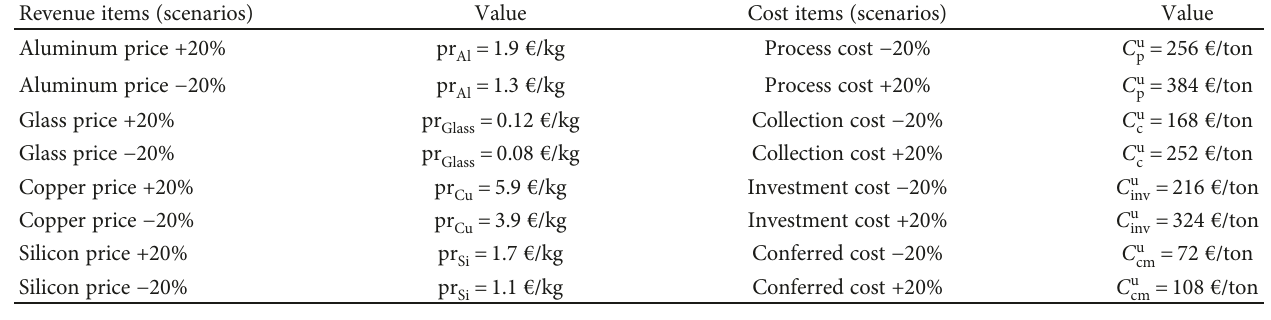
Figure 1: Percentage distribution of cash fl ows. Table 3: Alternative scenarios.